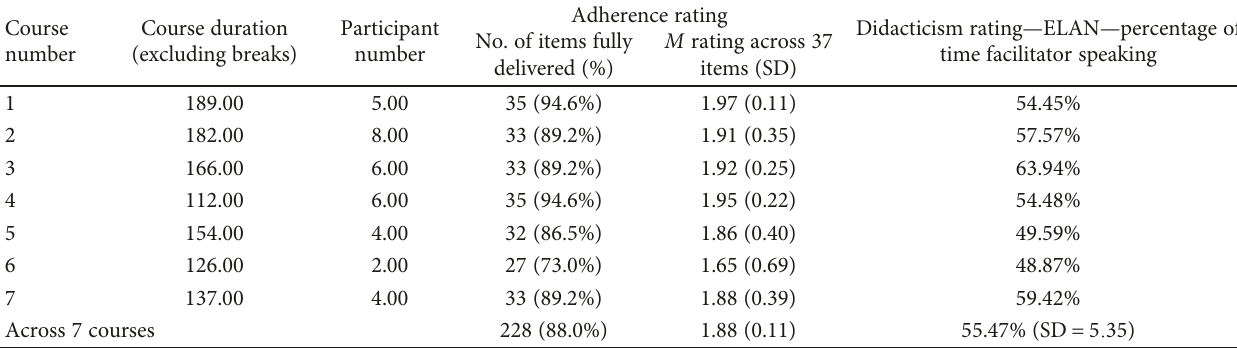
Table 2: Characteristics of the